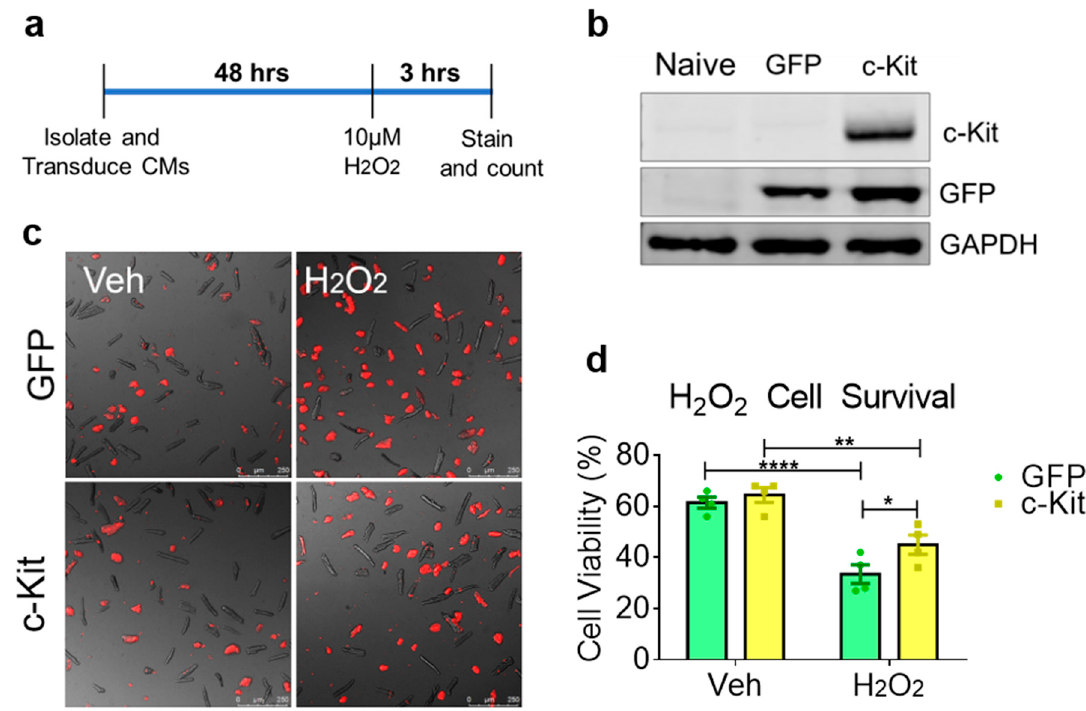
Figure 4. Cardiomyocytes with elevated c-Kit expression demonstrate enhanced resistance against oxidative stress. ( a ) Schematic showing the treatment procedure. ( b ) Immunoblot analysis of isolated cardiomyocytes transduced with GFP or c-Kit-GFP. ( c ) Fluorescent images of TO-PRO-3 staining on GFP or c-Kit-expressing cardiomyocytes treated with vehicle or H 2 O 2 overlaid with brightfield images depicting dead or dying cells in red. ( d ) Quantification of cell viability counted from fluorescent images. N = 4, 300–600 cardiomyocytes counted per group, error bars represent SEM, * p < 0.05, ** p < 0.01 and **** p < 0.0001 as measured by two-way ANOVA multiple comparison with Tukey.